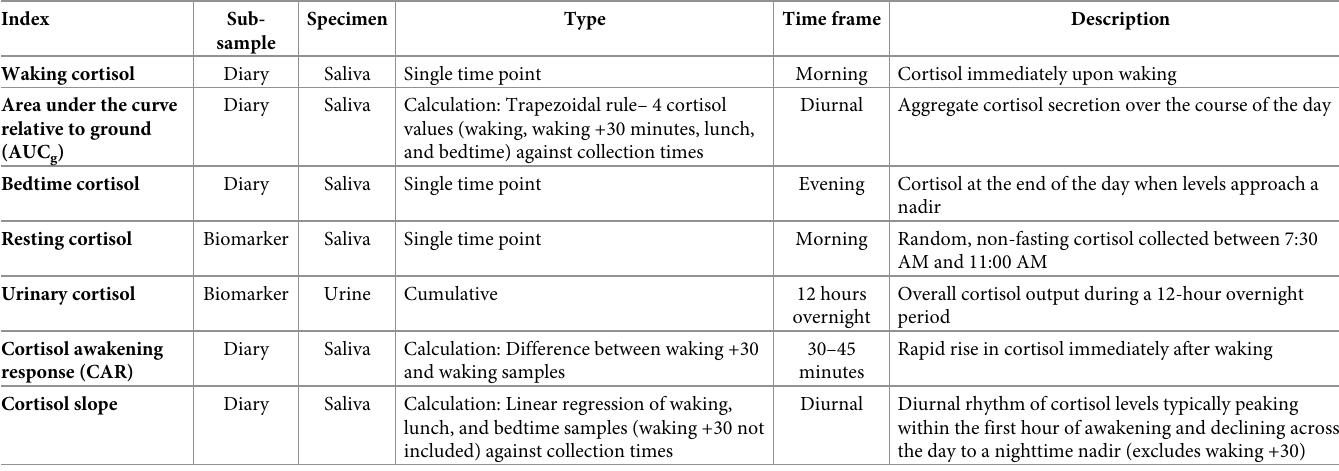
Table 1. Description of cortisol indices used in the current